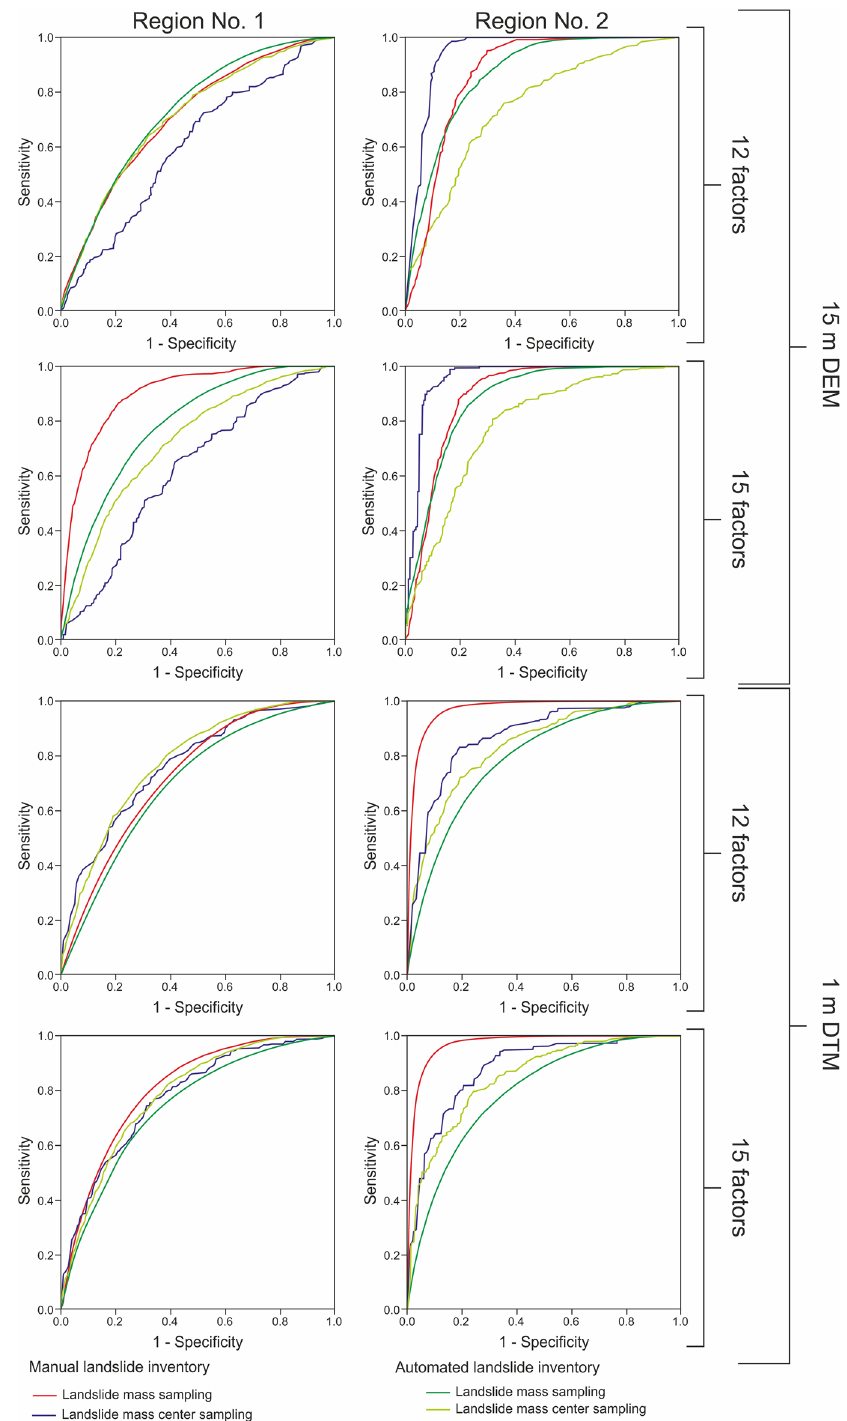
Figure 5. The receiver operation characteristic (ROC) curves for landslide susceptibility models for various input data. ROC curves were produced using IBM SPSS Statistics software (https:// www. ibm. com/ produ cts/ spss- stati stics), and the final layout was created in CorelDRAW 2018 (https:// www. corel draw. com/